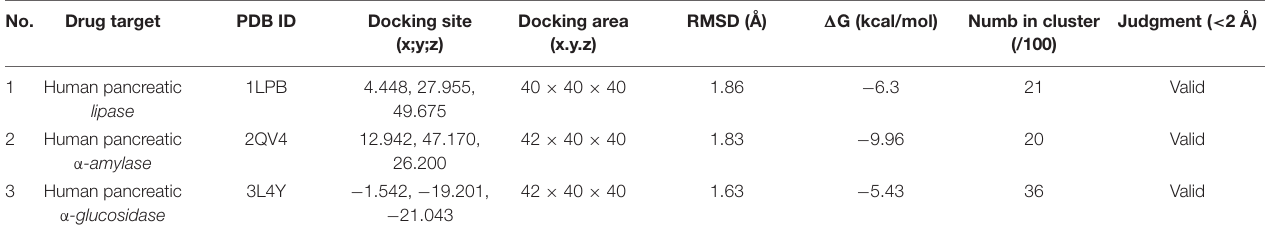
TABLE 2 | Validation of molecular docking simulation.